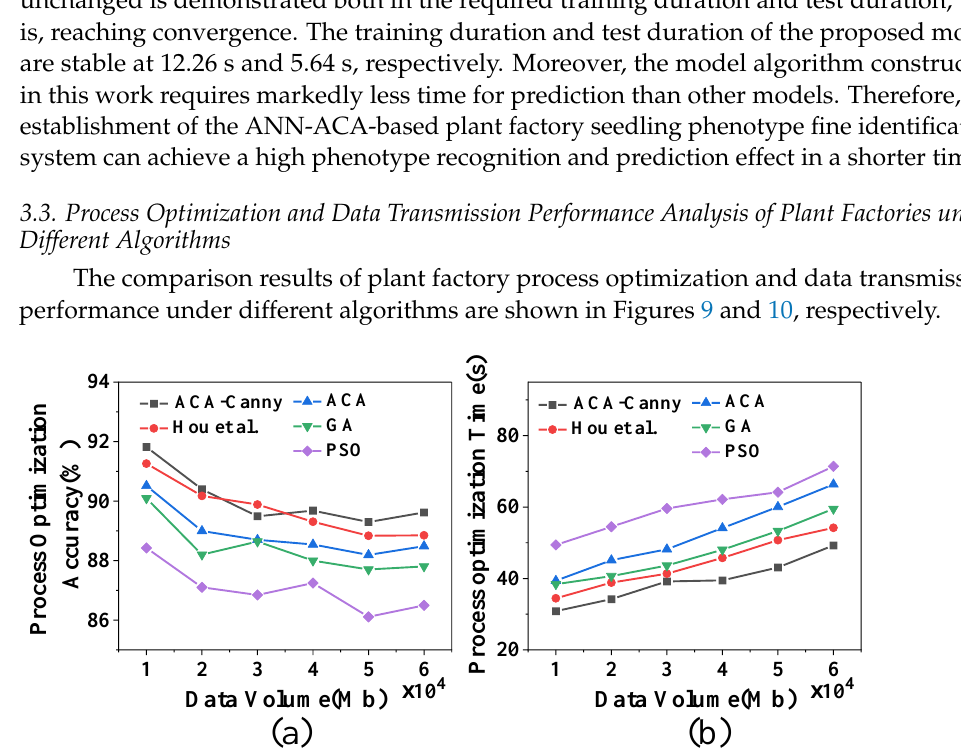
Figure 8. Comparison curves of the time required for phenotype recognition of various algorithms ( a ) training time; ( b ) testing time.